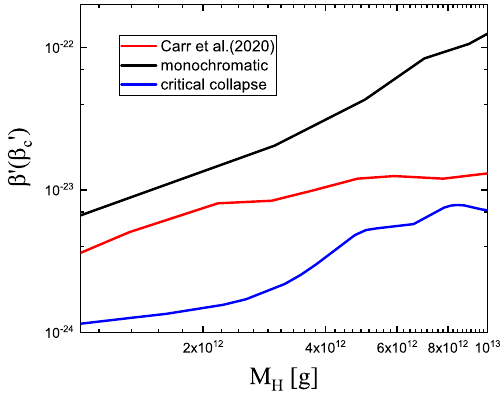
Figure 2. The upper bounds on β (cid:4) ( M H ) (the black curve) and β (cid:4) mass range M H = 10 12 − 10 13 g for the monochromatic and critical collapse mass functions, respectively, from the 3 He / H ratio in the present Galaxy. The red curve refers to the constraint from Carr et al.